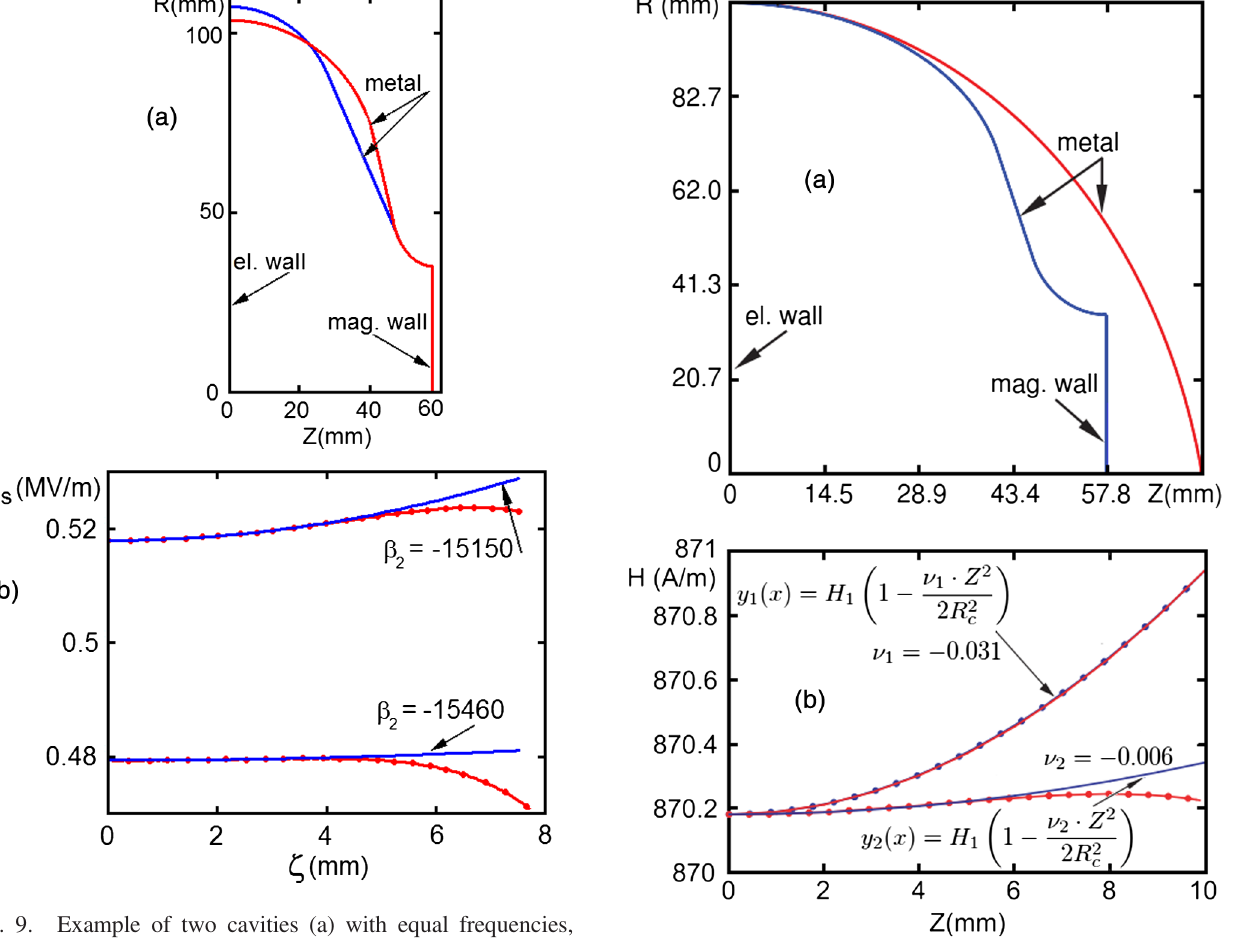
R , equal radii of curvature at the equator but different behavior eq of the magnetic fields near the equator (b). The curve H ð Z Þ with ν ¼ − 0 . 031 is for the TESLA inner